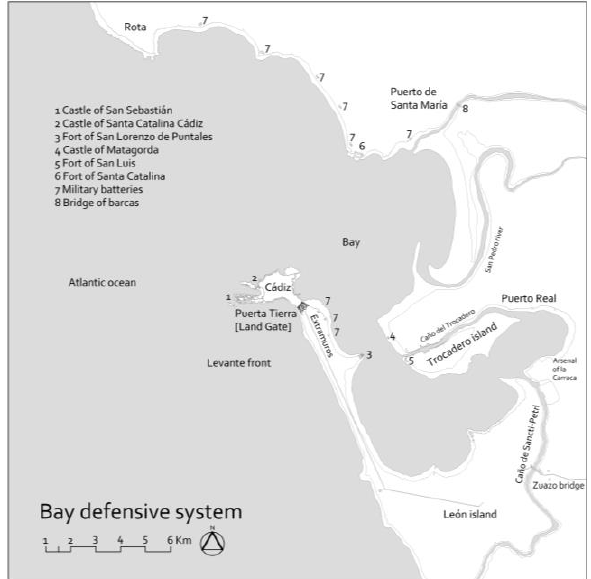
Figure 1. Location of Land Front with respect to the city of Cadiz and its bay. Own